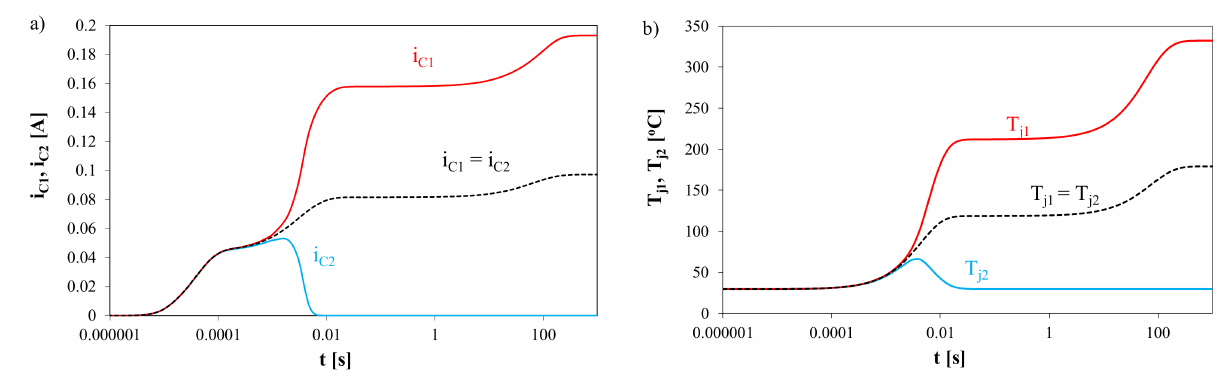
Figure 13. Collector currents ( a ) and junction temperatures ( b ) of BJTs having the same values of all the thermal parameters (dashed lines) and with different values of R th : R th 11 = 250 K/W, R th 22 = 240 K/W (solid lines).